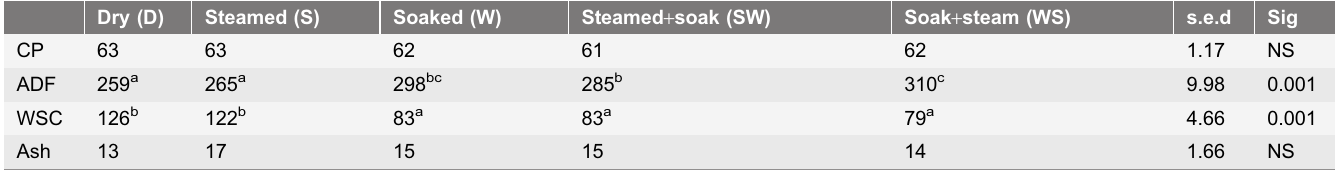
Table 2. Mean crude protein (CP), acid detergent fibre (NDF), water soluble carbohydrates (WSC) and ash contents (g/kg DM) of five different UK conserved hays when subjected to five different wetting treatments. Dry